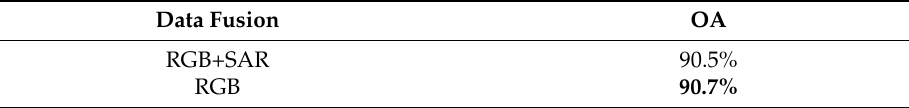
Table 9. OA of SAR and optical data fusion.